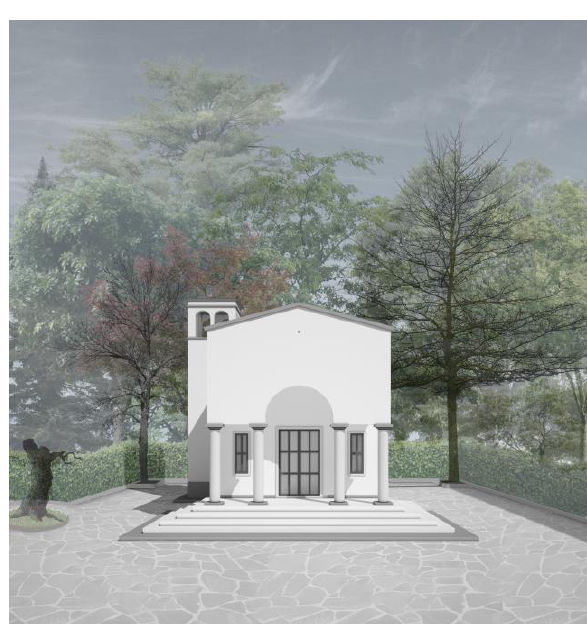
Figure 13. The Royal Park of Tirana. Render of the Church.